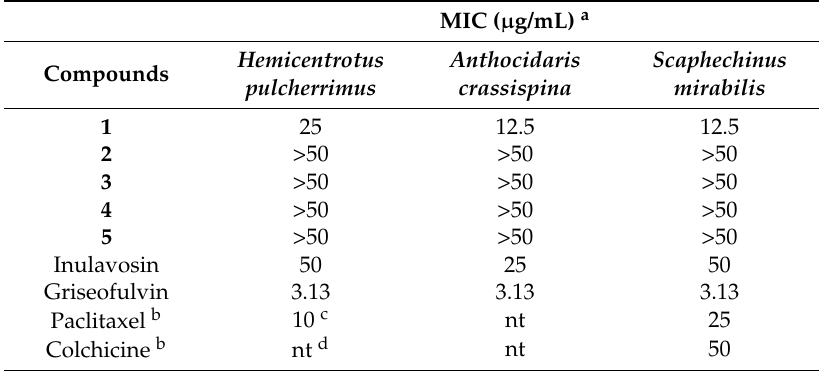
Table 2. Inhibitory effects of the selected compounds against mitosis of sea urchin embryos.